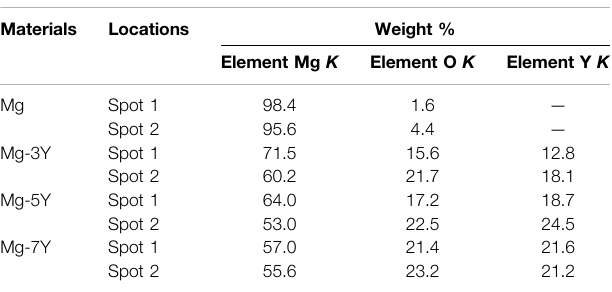
TABLE 5 | The EDS mapping analysis of different